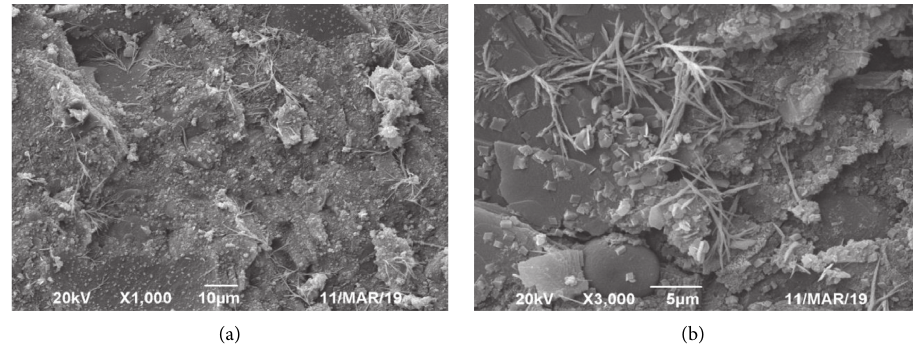
Figure 9: Microstructure of UHPC with LC-NC additives